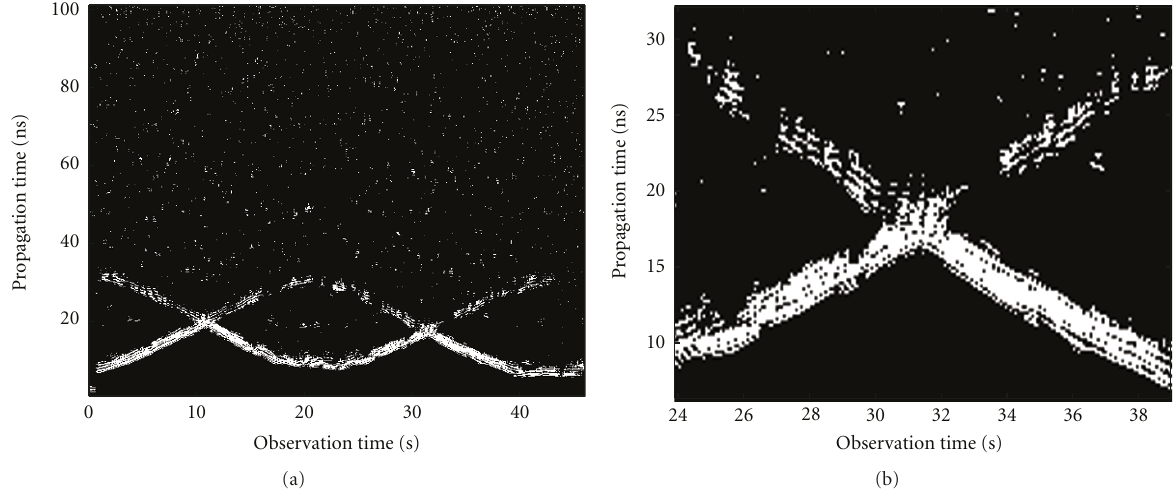
Figure 2: Detector output for the first receiving antenna Rx 1 : (a) complete radargram with traces of two moving targets, (b) distributed target trace